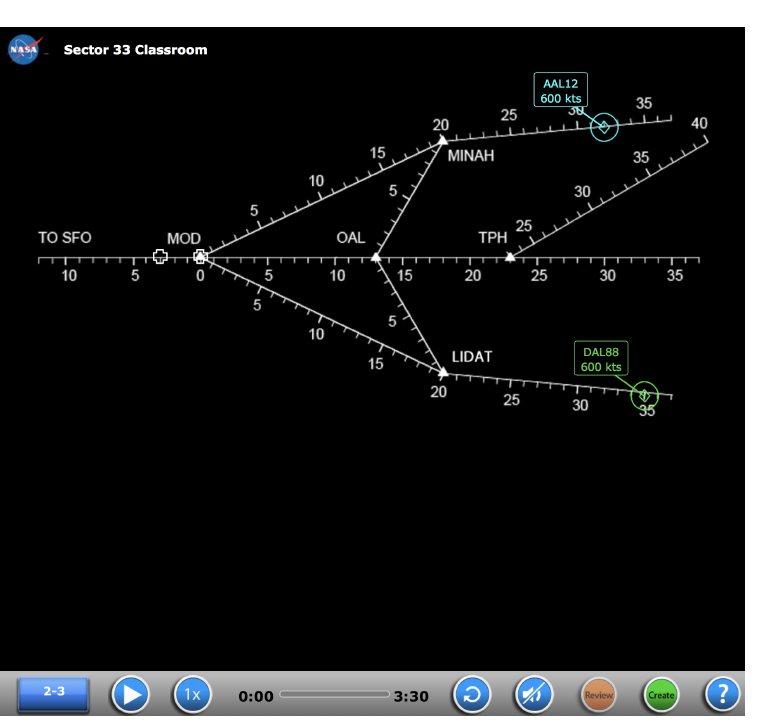
Figure 9. Example of a state of parent agent. Reprinted with permission from [26]. 2018,